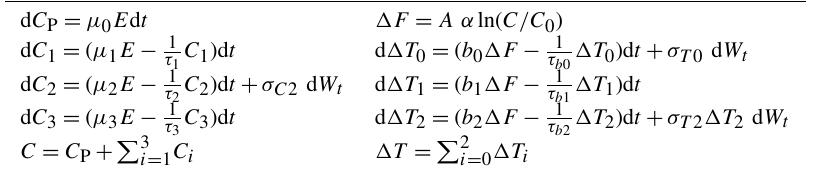
Table 1. Stochastic state-space model. Carbon model on the left, temperature model on the right. W t denotes the Wiener process.